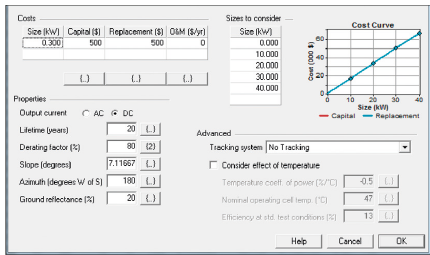
Figure 15: The design of the photovoltaic power generation system in Homer software.